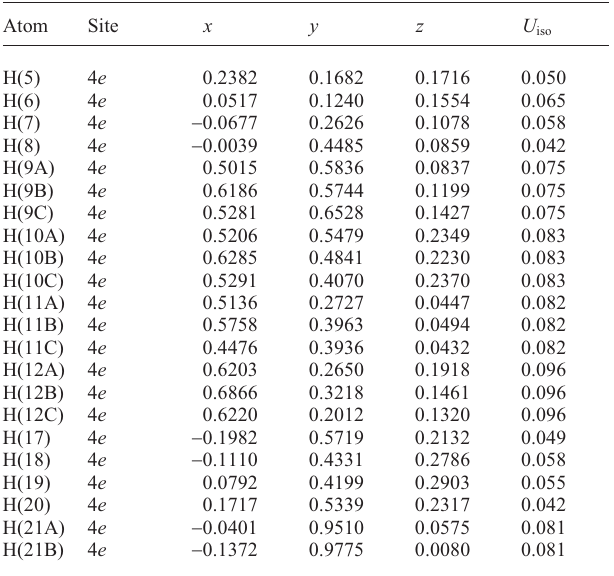
Table 2. Atomic coordinates and displacement parameters (in Å 2 )